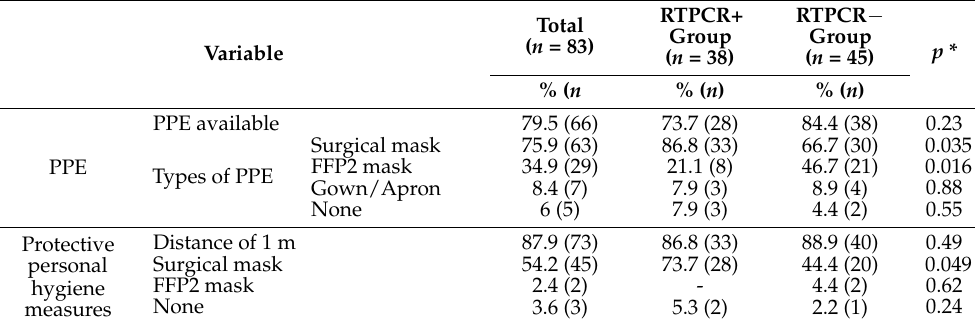
Table 6. The use of personal protective equipment and comparison between the RTPCR+ and RTPCR −